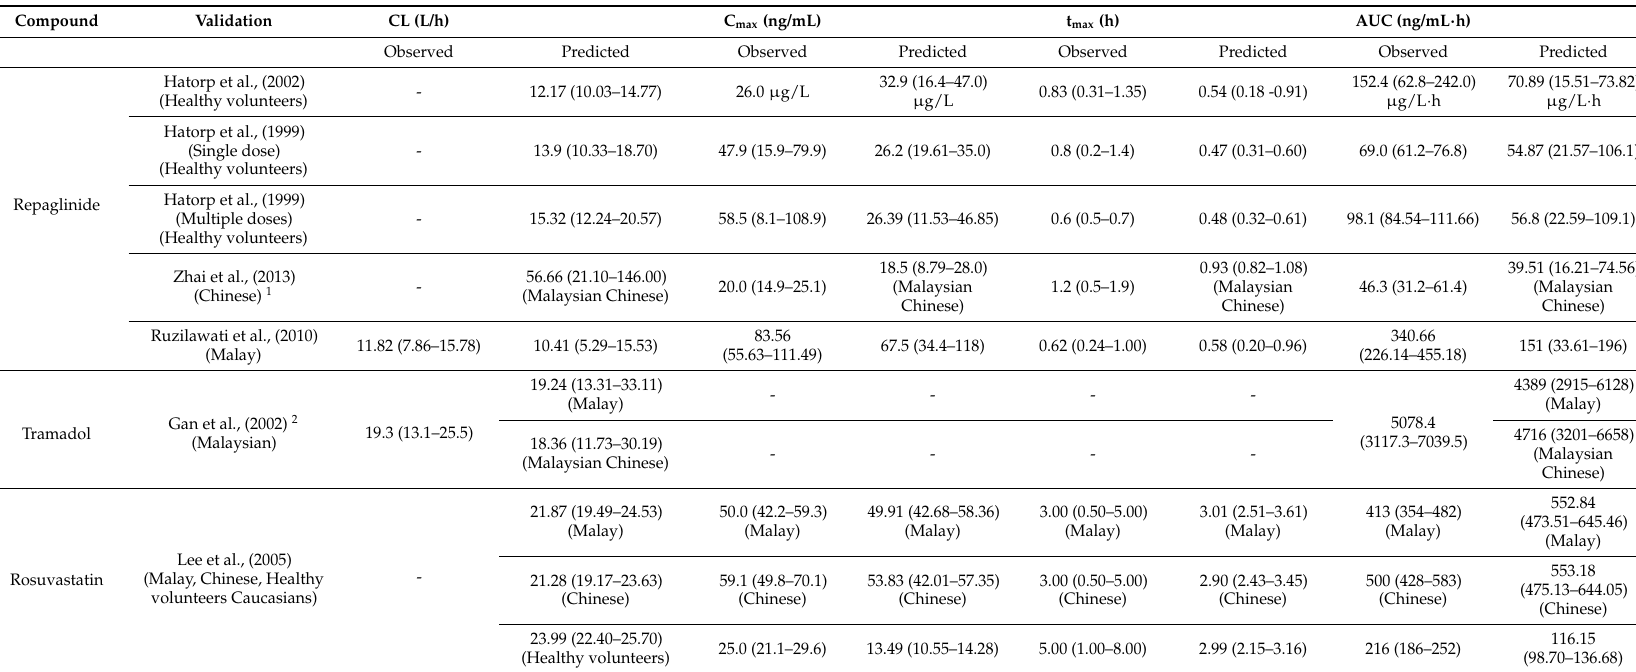
Table 2. Summary of predicted and observed pharmacokinetic parameters of repaglinide, tramadol and